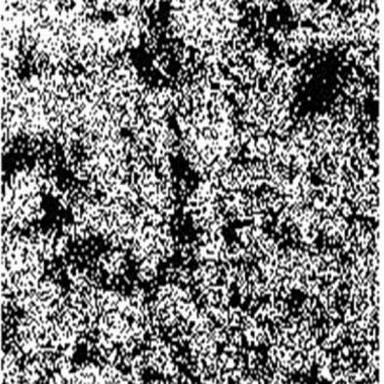
X-ray microanalysis of powders obtained by wet and dry milling: distribution maps of the Fe, Co, Nb, chemical elements on the starting sample (a) and the 5 h wet-milled sample (b) and 5 h dry-milled sample (c).